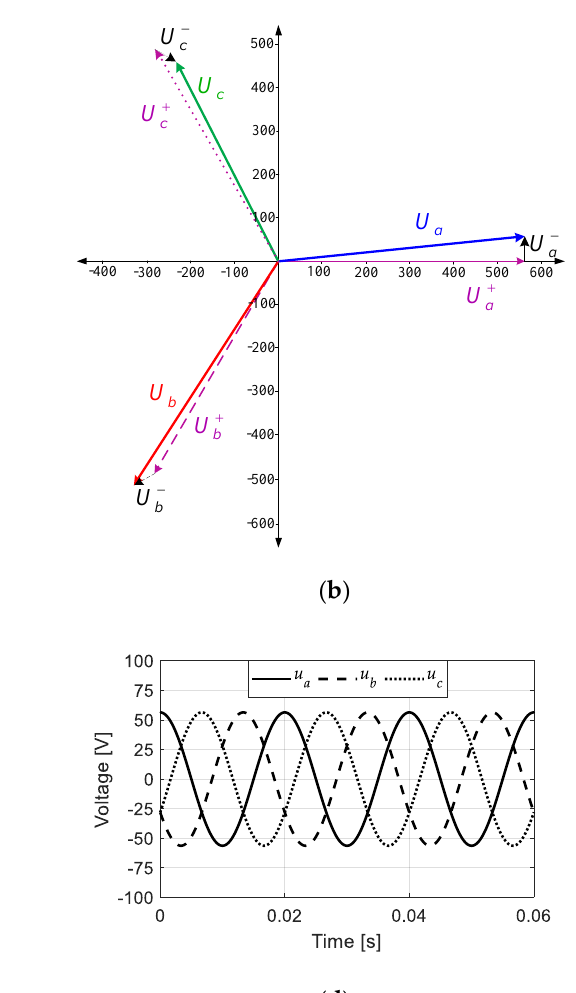
Energies 2021 , 14 , x FOR PEER REVIEW 7 of 25